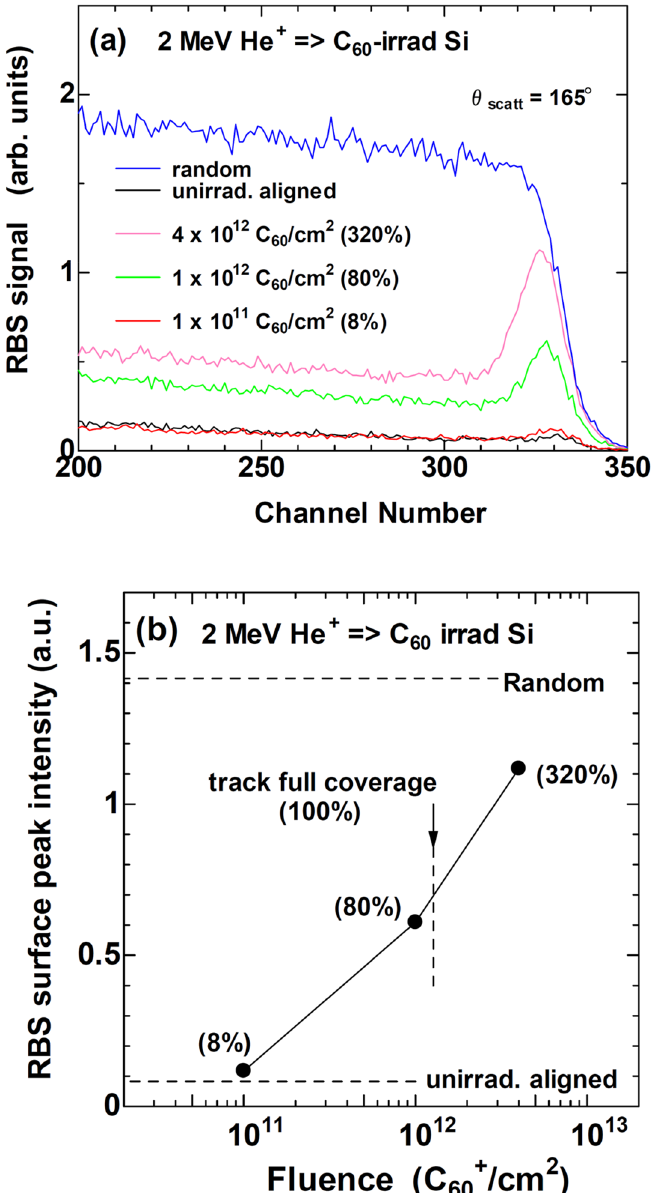
Figure 6. ( a ) RBS/C spectra of c-Si in unirradiated state and irradiated with 6 MeV C 60+ ions to three different fluences. ( b ) Fluence dependence of the surface peak around 330 channel. Horizontal broken lines indicate the random and aligned levels in unirradiated sample. Numbers in parentheses indicate the track coverage ratio at the fluences, which is defined by eq. (6). The vertical broken line indicates the track full coverage, i.e.,